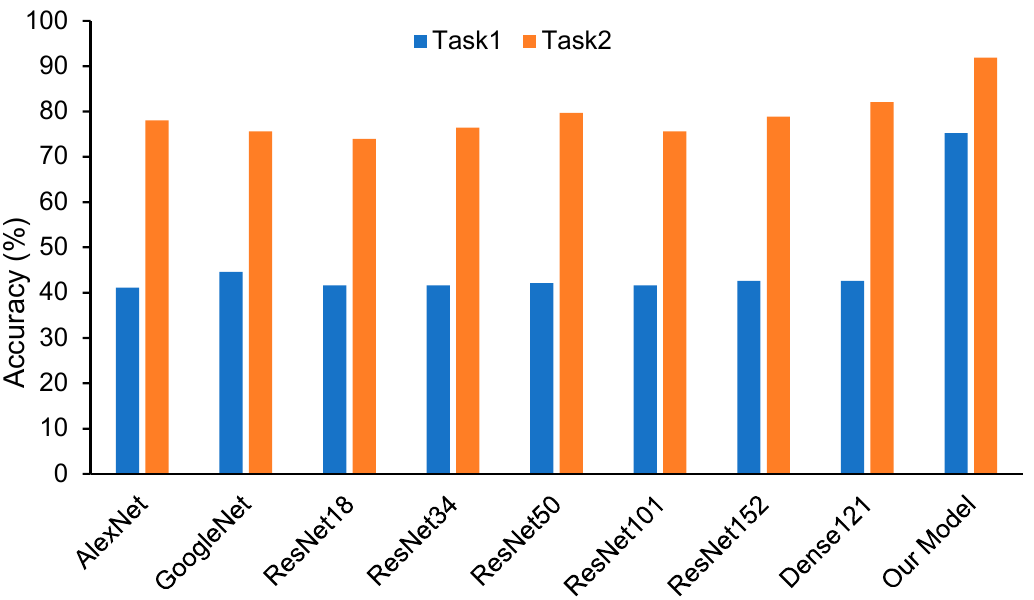
Figure A4. The heat maps of the deep image features for the proposed DNN model.